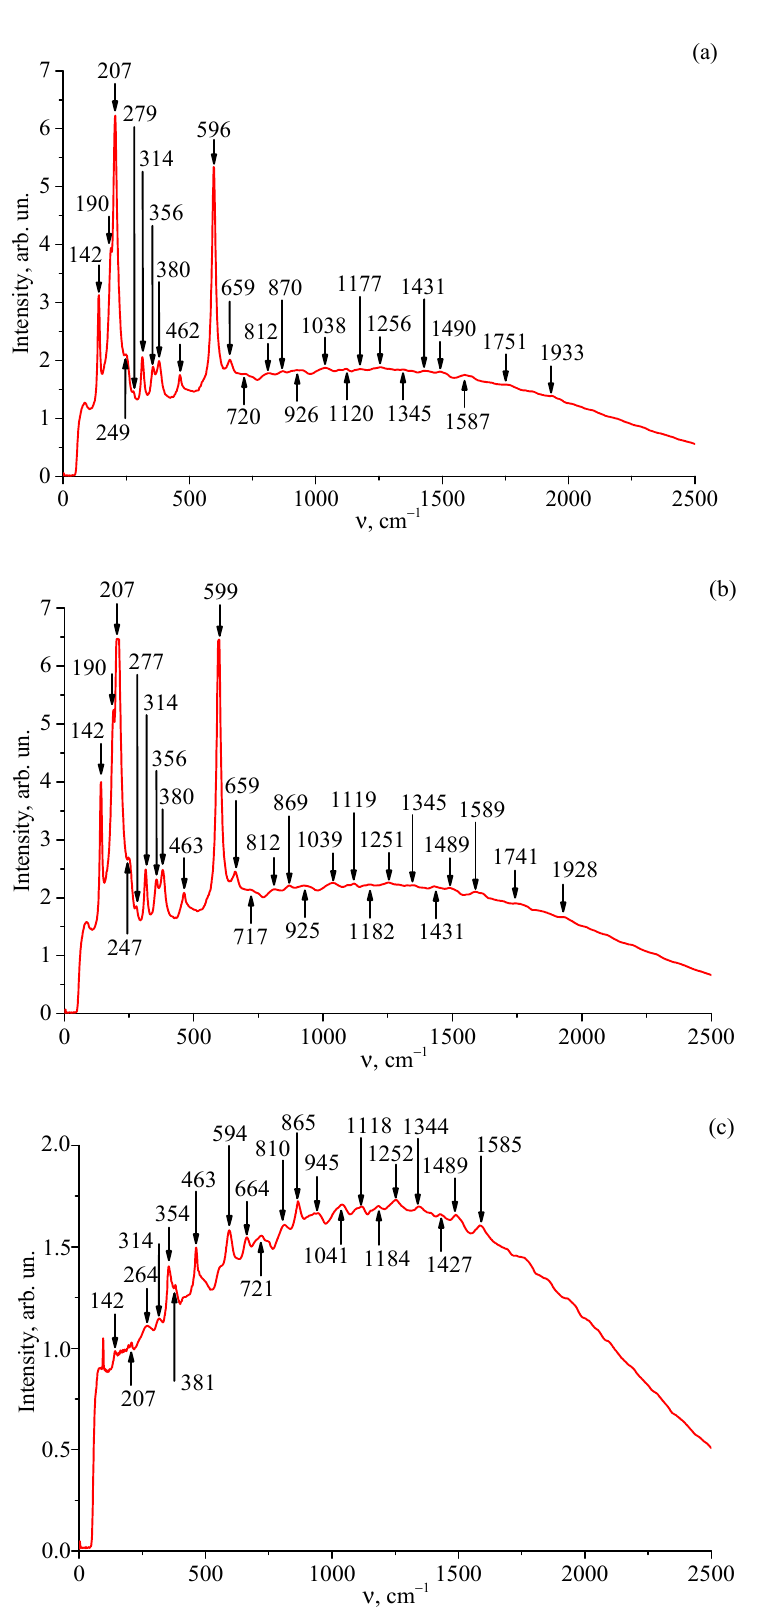
Figure 3. Raman spectra excited by λ 0 = 785 nm radiation in the LT:Cr crystal in scattering geometries x(zz, zy)x ( a ), y(zz, zx)y ( b ) and z(xx,yy,xy)z ( c ).